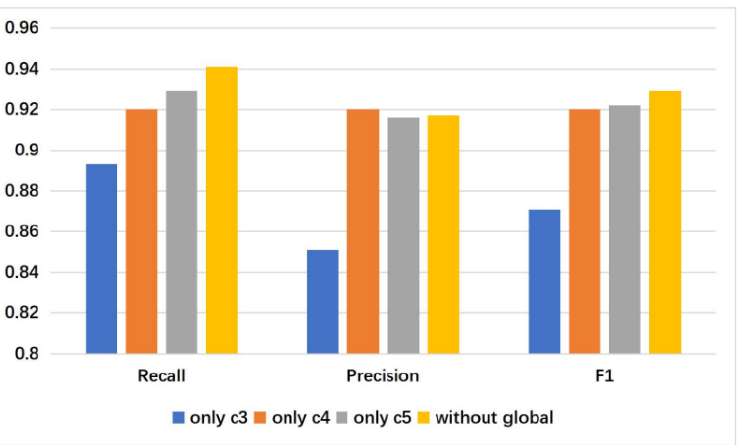
Figure 7. The performance with different levels of context features and global features removed on FI dataset.